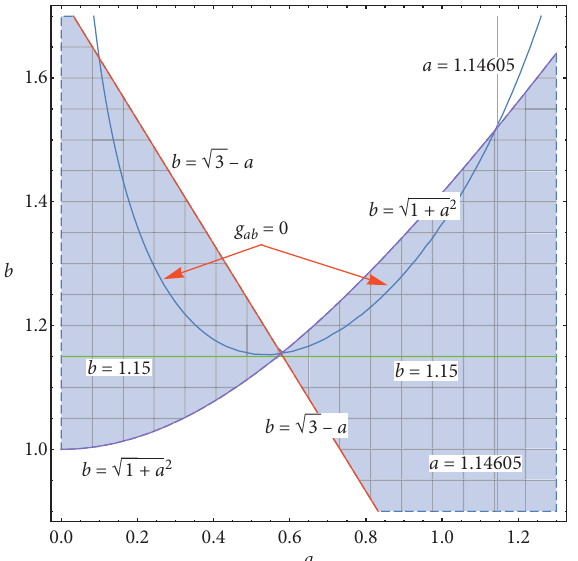
Figure 3: Region of existence of central configuration for the concave kite four-body problem with ( m